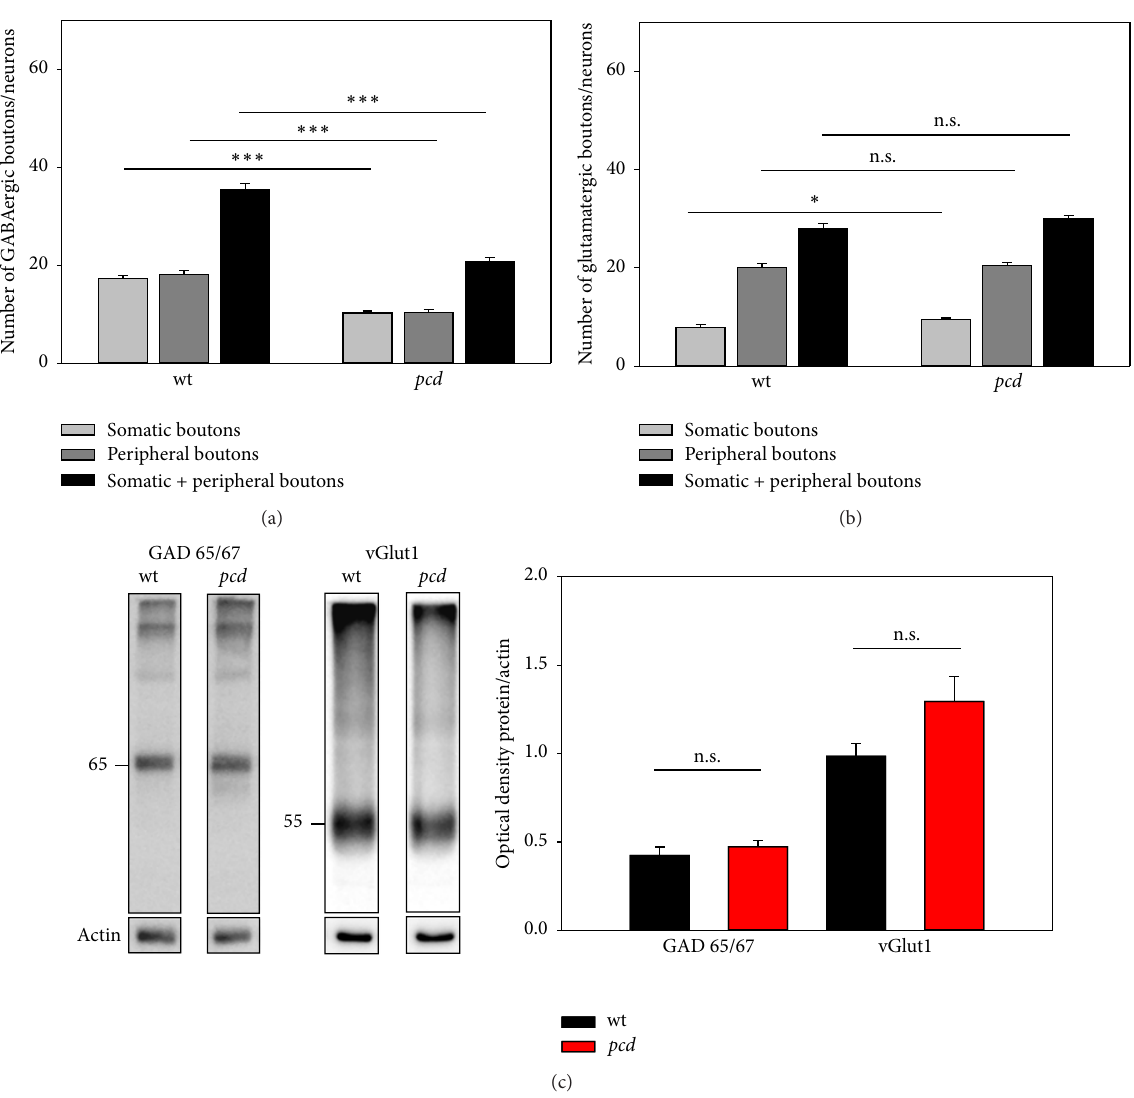
Figure 3: Quantification of GAD65/67 and vGlut in DCN. (a) Quantification shows the distribution of GABAergic terminals in different distances from the PN-bearing neurons. The total number of boutons are reduced in pcd compared to wt , regardless of the distance. (b) Somatic glutamatergic terminals at DCN neurons appear to be enhanced in pcd mice. The peripheral synapses remain unaffected by the insult. (c) Western blot analyses of GAD65/67 and vGlut1 with protein extracts of DCN sections. Typical specific bands are visible in both genotypes. Quantification of these bands reveals slight but no significant differences between wt and pcd (GAD65/67 𝑝 = 0.419 ; vGlut1 𝑝 = 0.087 ). Data are given as mean ± SEM. significant differences (Figure 3(c); wt : 0.423 ± 0.05 and pcd : 0.473 ± 0.03 𝑡 -test 𝑝 = 0.419